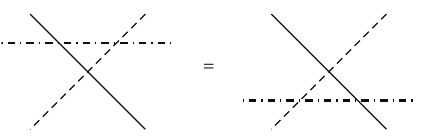
For three colors with the same adjacency as { 1 , 2 , 3 } ,